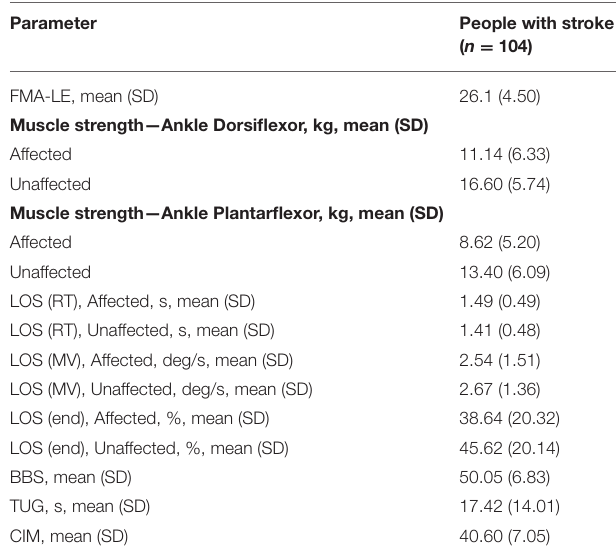
TABLE 3 | Mean Stroke-specific impairment outcome measurements for people with stroke.